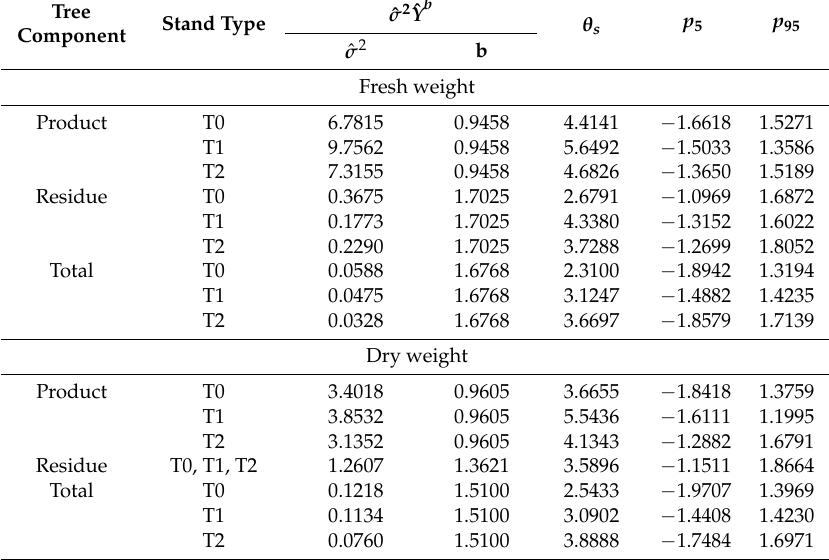
Table 6. Estimated scale factors ˆ σ 2 and exponents of the residual variance functions for product, residue and total tree fresh and dry weight predicted by the system of additive equations with the incorporation of dummy variables for stand types, using D as the independent variable (Equation (9)). θ s is Snowdon’s bias correction factor, p 5 and p 95 are the fifth and ninety-fifth percentiles of the weighted residuals. Tree